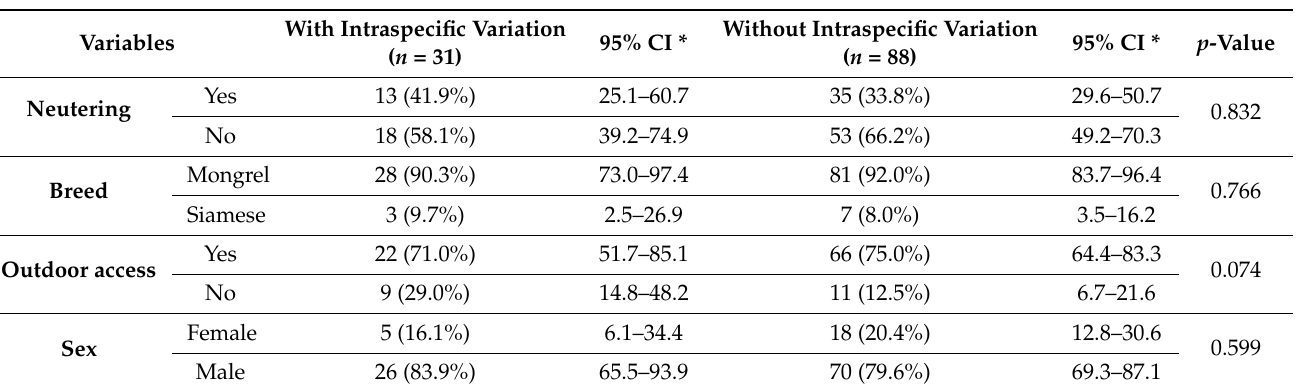
Table 3. Distribution of epidemiological variables in the 119 cats with sporotrichosis according to the presence or absence of intraspecific genotypic variation in the S. brasiliensis isolates obtained from these animals. Rio de Janeiro, Brazil (1998 to